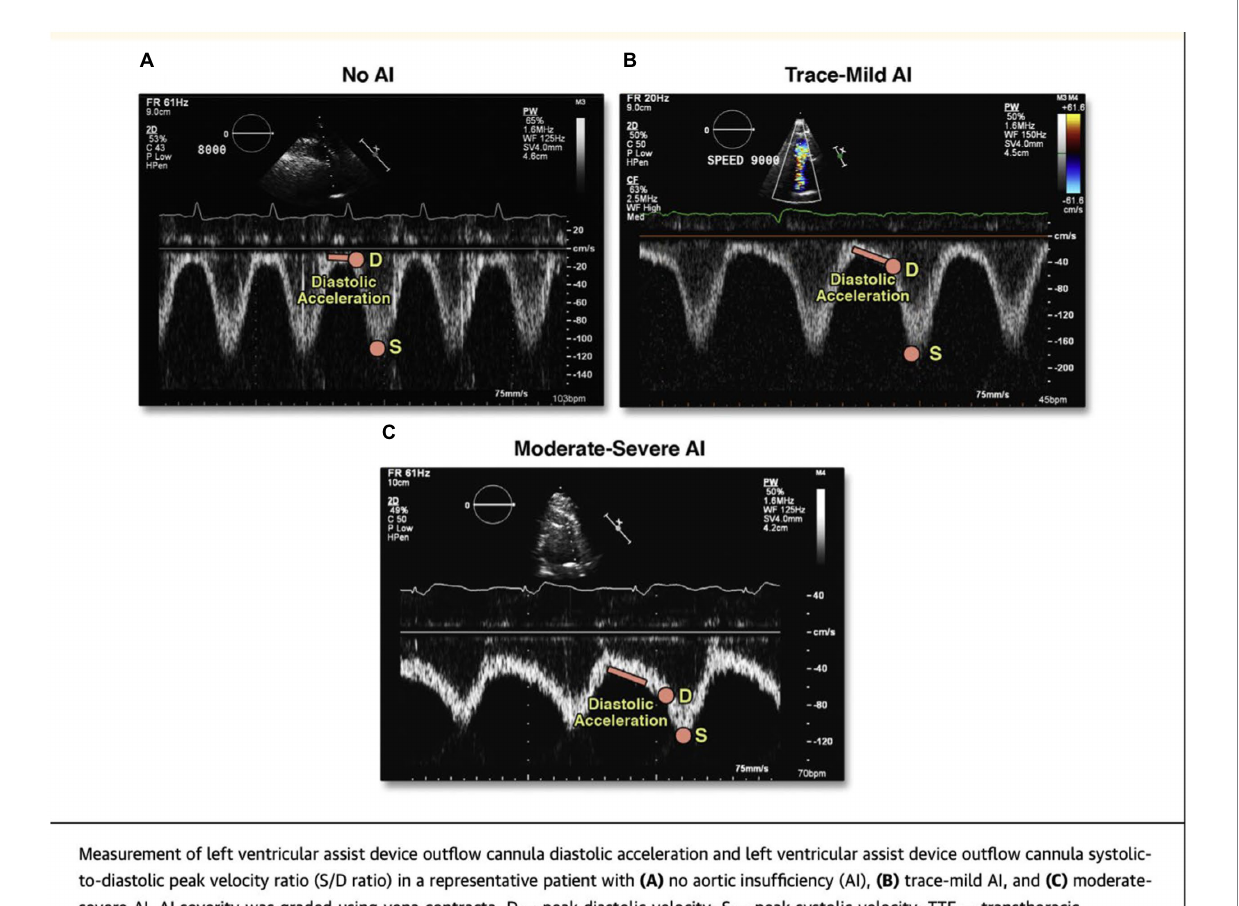
FIGURE 3 Novel echocardiographic parameters for assessment of LVAD-AI. Reproduced with permission from